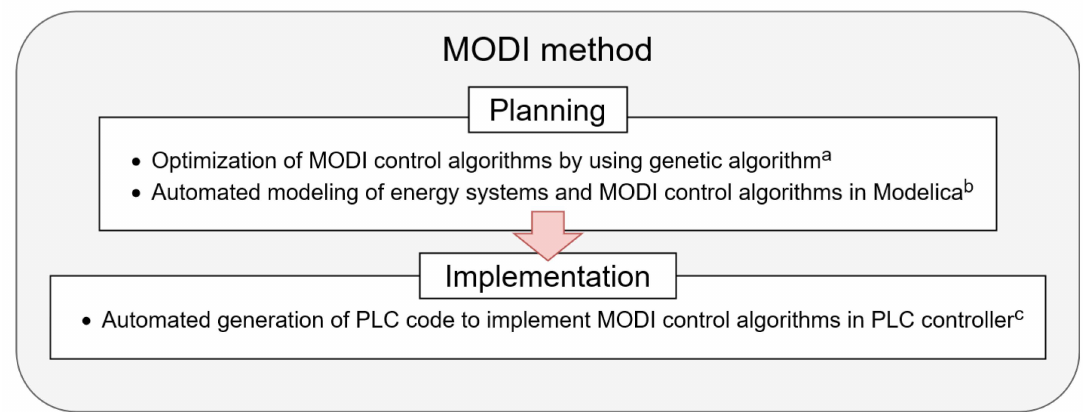
Figure 17. The further investigations of the MODI method to enable a digitized planning and implementation process of building automation, a: [57]; b: [63]; c: